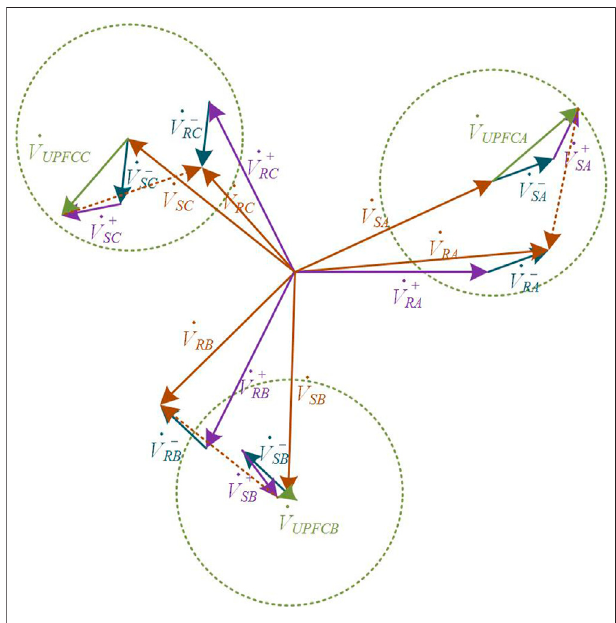
FIGURE 7 | Phasor diagram of UPFC with unbalanced grid condition